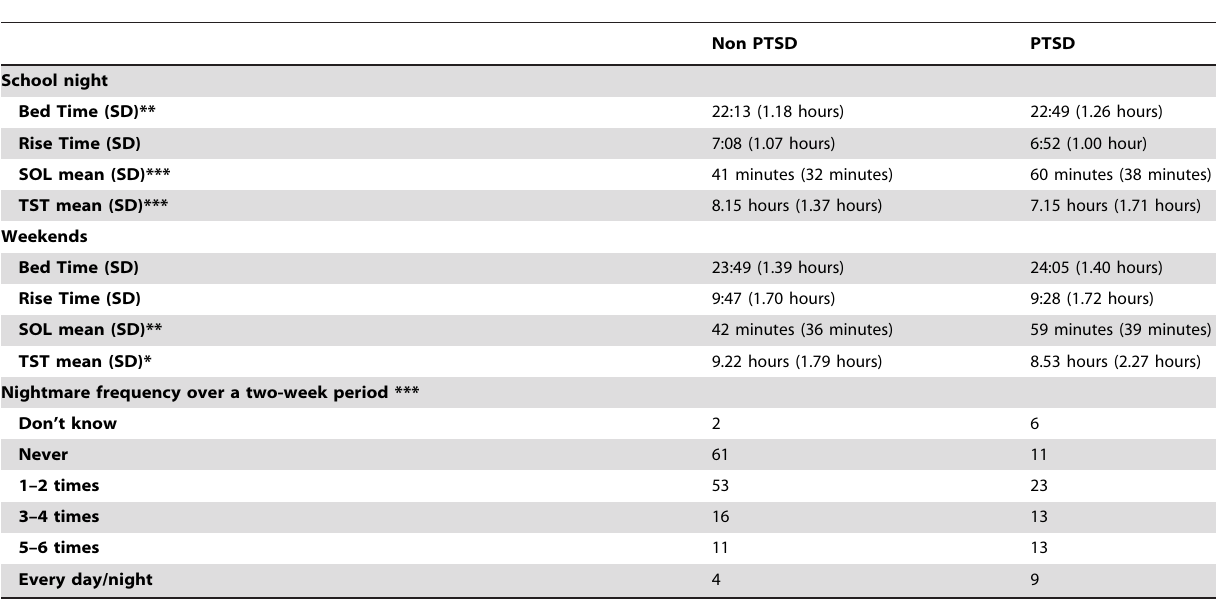
Table 4. ANOVA results of total sleep time, bed times, rise times, sleep onset latency for school nights and weekends along with nightmare